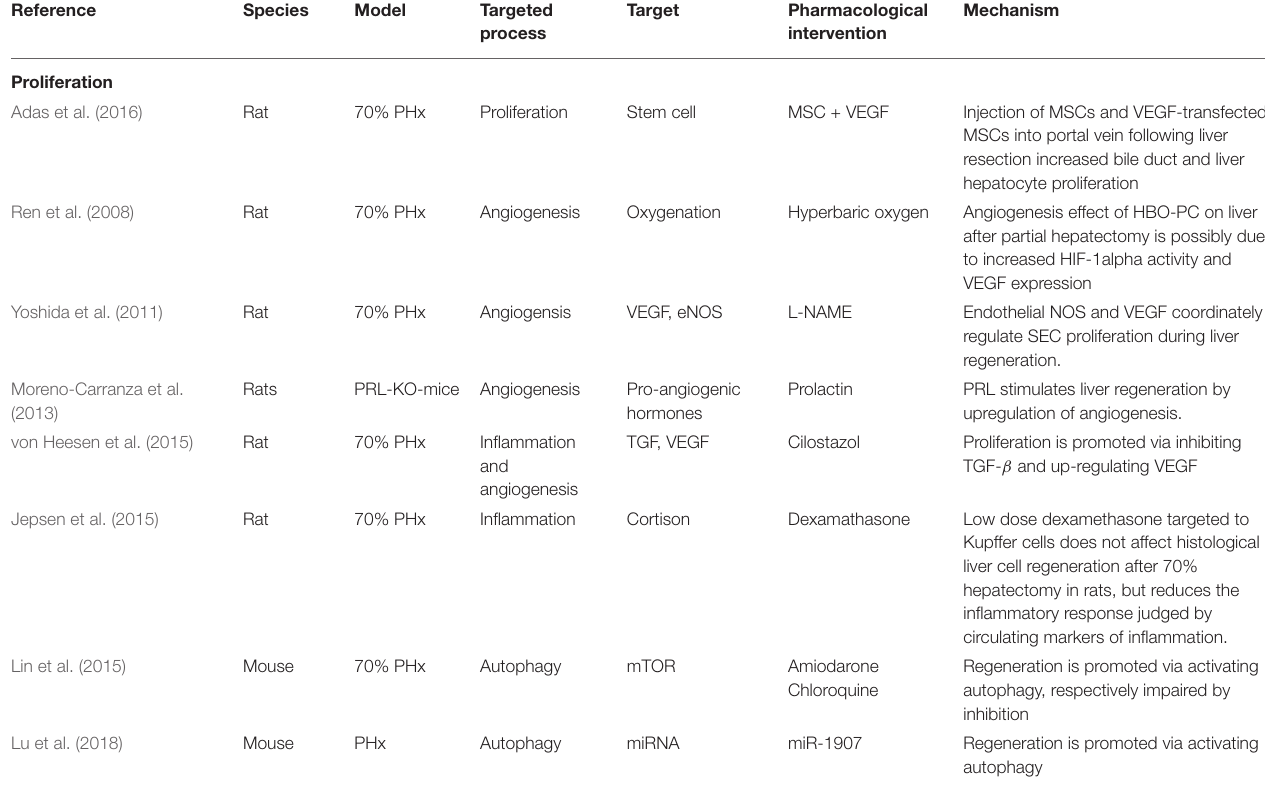
TABLE 3 | Selection of classical interventional studies exploring molecular